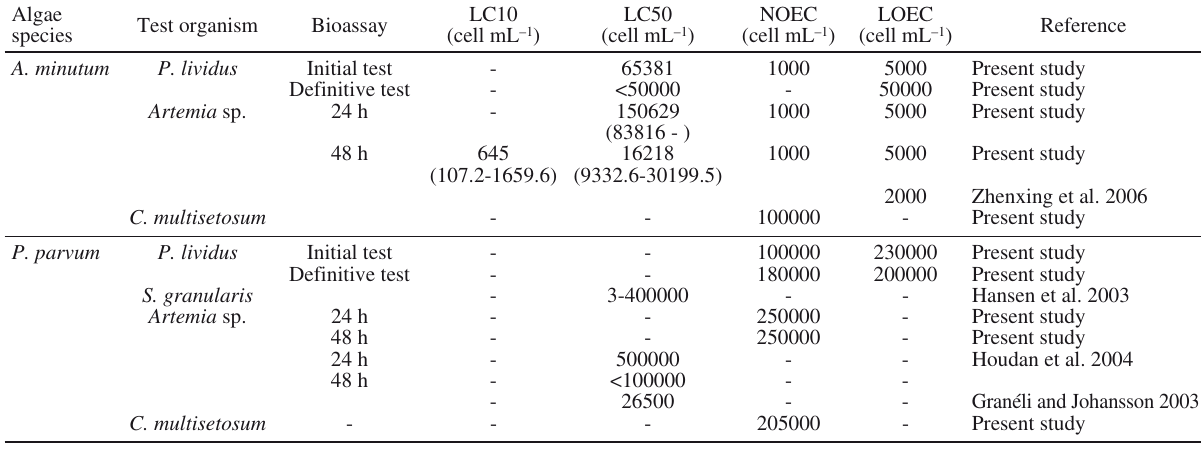
Table 4. – Lethal concentration (mg L –1 ) for Alexandrium minutum and Primnesium parvum (LC Algae species